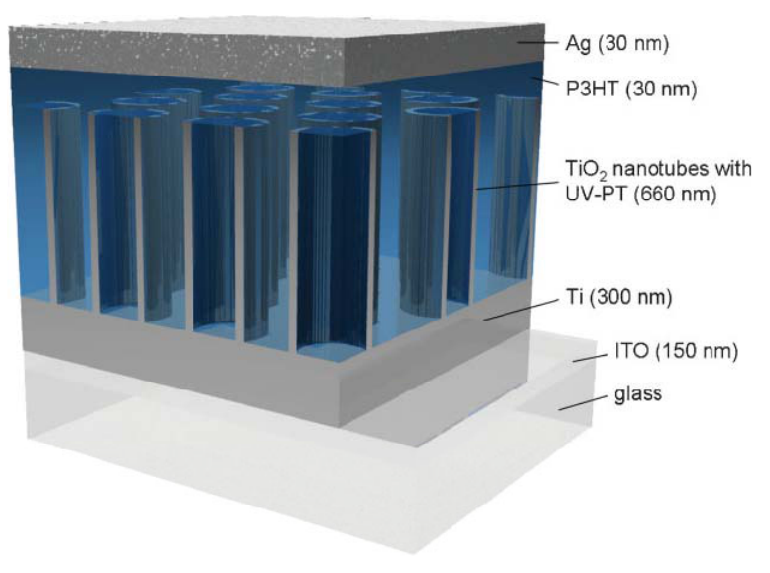
Figure 2. Solid-state solar cell with nanotubes sensitized by polythiophene polymerized in the nanotubes. Reprinted with permission from [21]. Copyright 2009